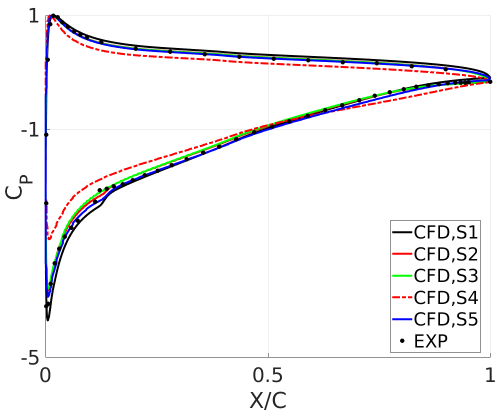
Figure 4. Chordwise C p distribution at mid-height section of the wing for the simulations with the different spanwise setup (Table 1), as well as the experiments; AOA = 11 ◦ .